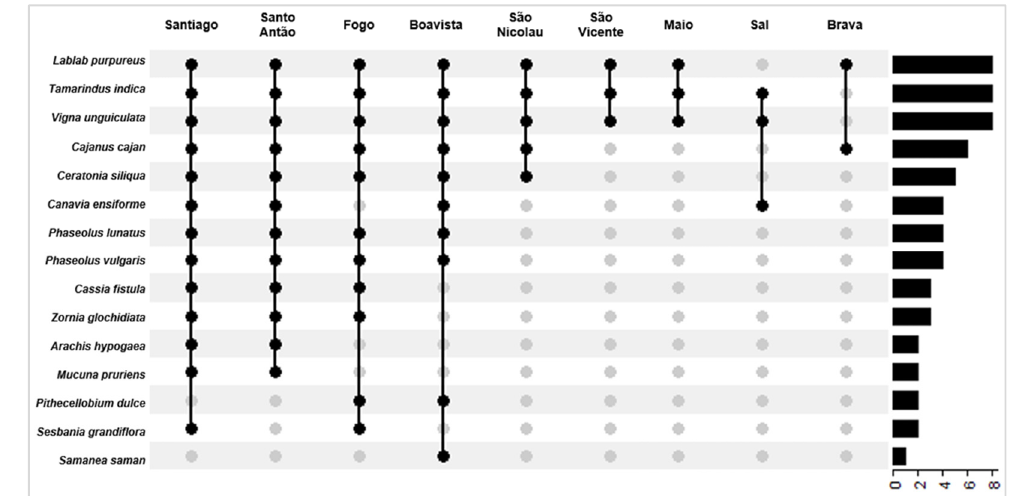
Figure 2. Distribution of the food legume species in Cabo Verde. UpSet diagram showing the presence and number of species per island. The lines linking the dots represent species that occur in two or more islands.